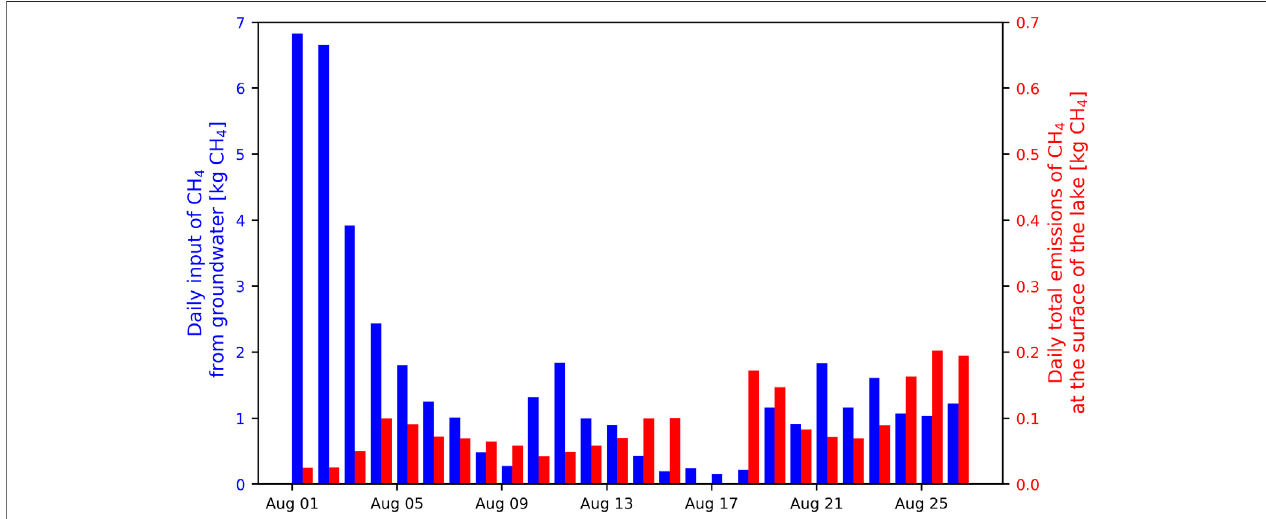
FIGURE7| ComparisonbetweentheestimateddailyinputofCH 4 fromthemiretoStortjärn(bluebars)andthetotalamountofCH 4 emittedeachdayatthesurface of the lake (red bars; note the tenfold difference between left and right y-axes scales). Emissions of CH 4 at the surface of the lake were not measured on 16 – 17 August.